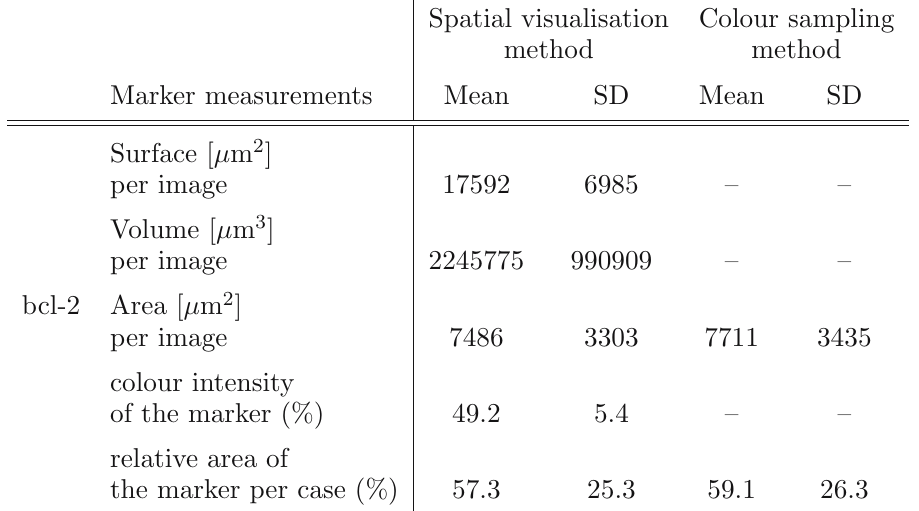
Table 3 Quantitative measurements of bcl-2 in twenty chronic parathyroiditis cases.